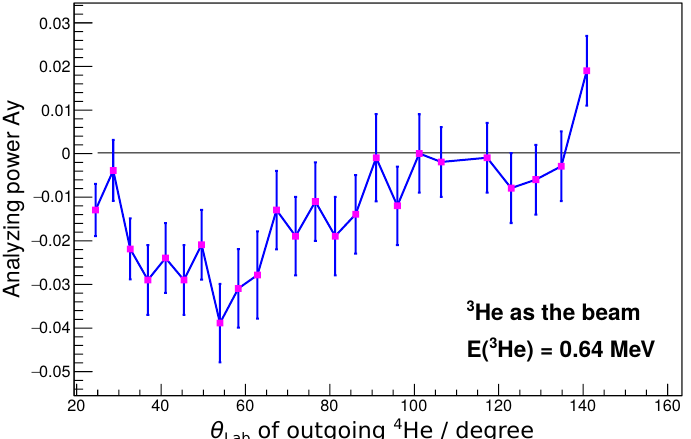
Figure 13. Analyzing power of the d - 3 He fusion reaction in the Lab frame at the 0.64-MeV resonance in dependence of the 4 He polar angle. The values of A y are transformed from the CM to the Lab frame using data obtained with a polarized 3 He gas target at a deuteron beam energy of 0.43MeV